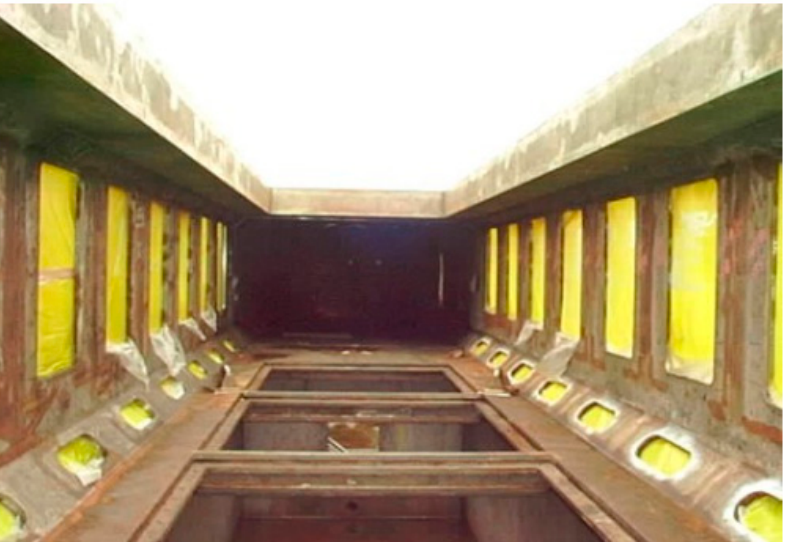
Figure 15. Photograph of the inside of the large cavitation tank at National Taiwan Ocean University.